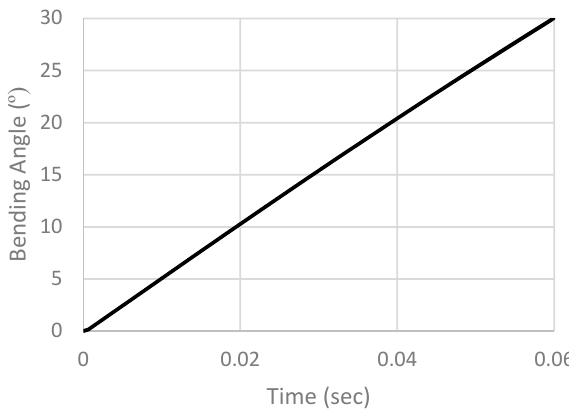
Figure 20. Open loop simulation results.